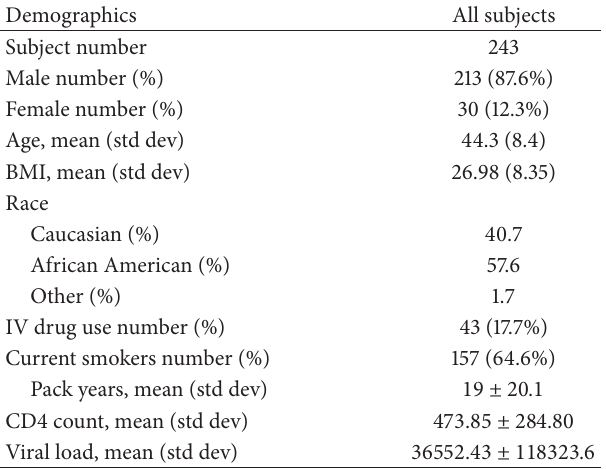
Table 1: Baseline demographics of the study